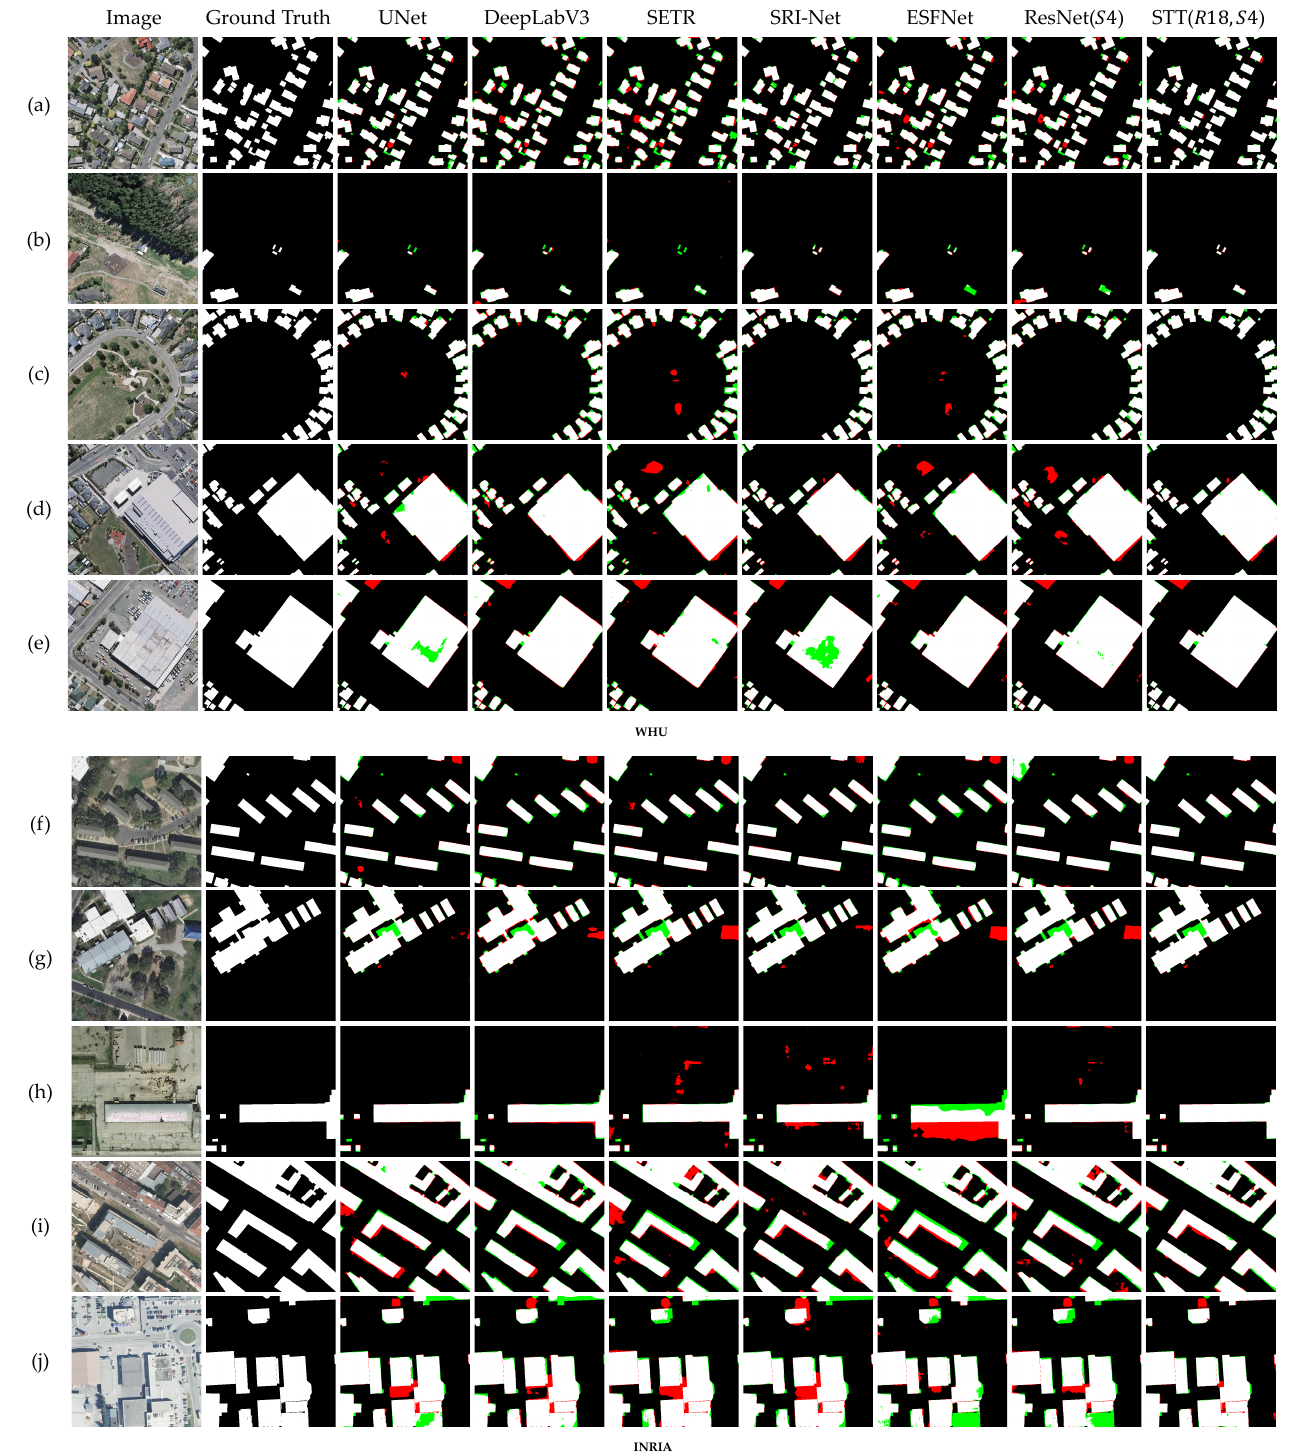
Figure 4. The results of different methods on samples from the WHU ( a – e ) and INRIA ( f – j ) building datasets are visualized. The figure is colored differently to facilitate viewing, with white representing true positive pixels, black representing true negative pixels, red representing false positive pixels, and green representing false negative